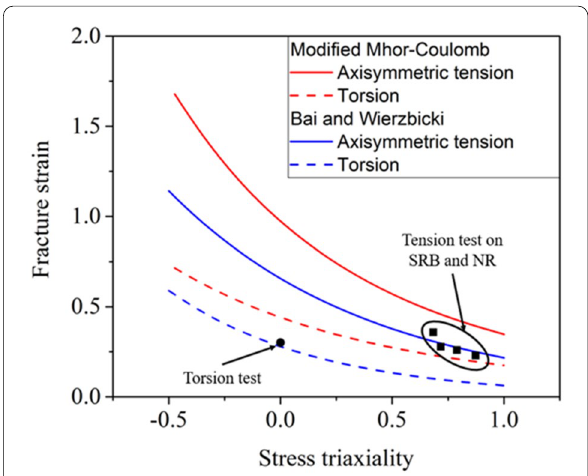
Figure 16 Relationship of fracture strain and ST